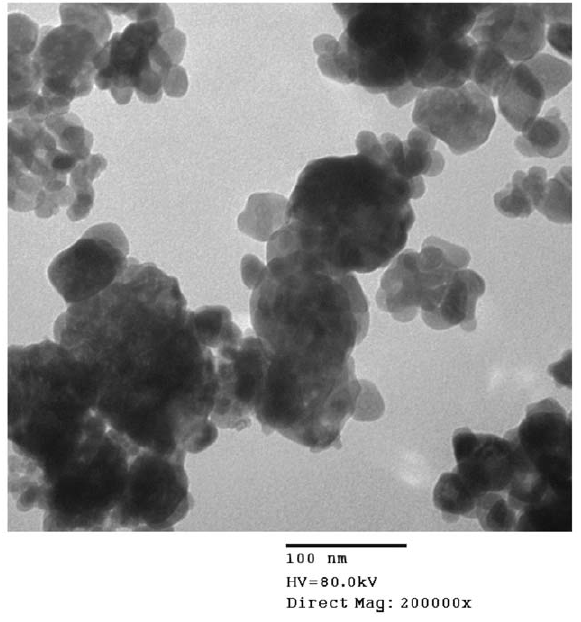
Figure 1. The transmission electron microscope (TEM) image of nFe 2 O 3 aggregates (10 mg/L) in zebrafish culture medium.